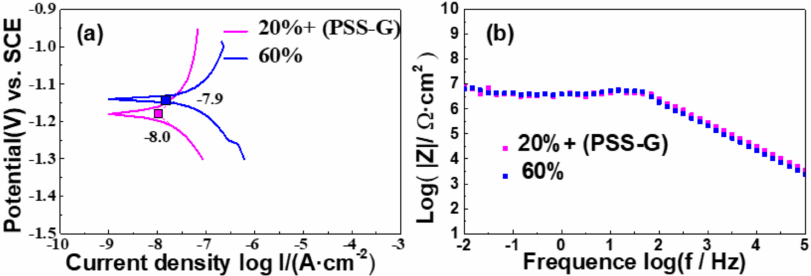
Figure 8. ( a ) Tafel polarization curves and ( b ) Bode plots of the pure coating with 60% zinc contents and PSS-G / coating with 20% zinc contents. (The blue line is for zinc-containing coating with zinc content of 60%, the violet line is for epoxy / PSS-G